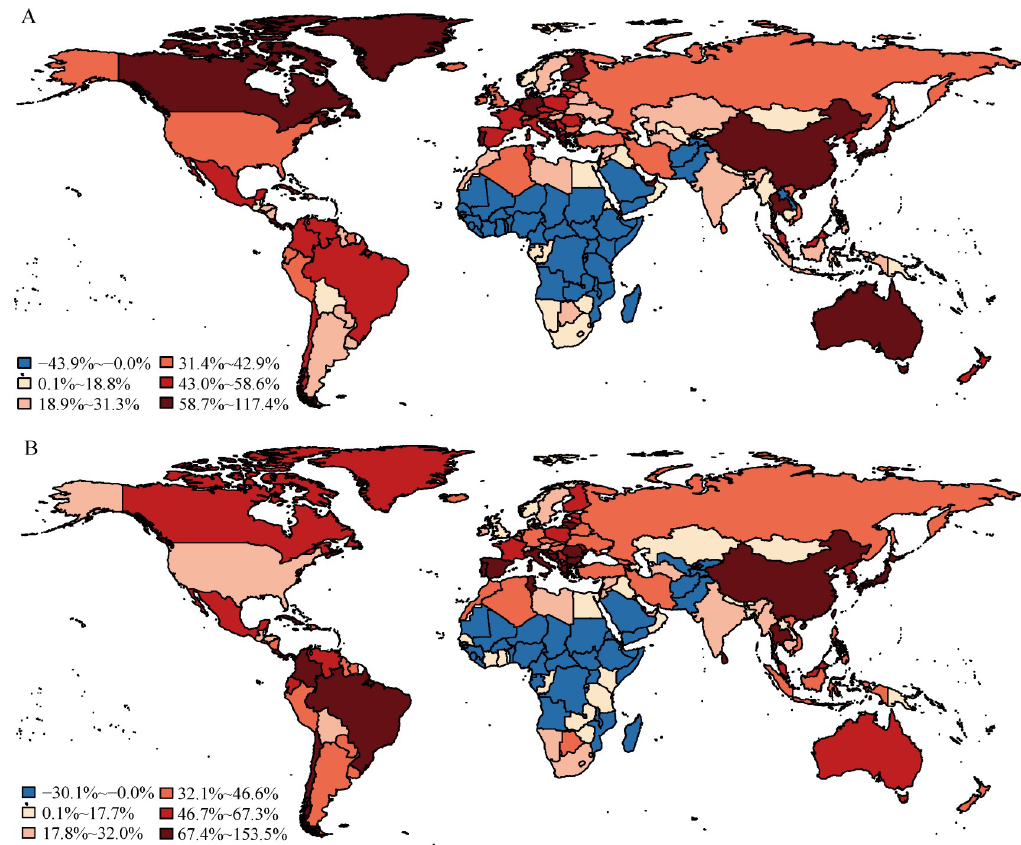
Fig 3. Proportion of deaths associated with population ageing between 1990 and 2017 in 195 countries and territories. (A) Male; (B) female. The attributed proportion was calculated as the change in total deaths attributed to population ageing between 1990 and 2017 divided by total deaths in 1990 × 100%. Countries and territories with negative attributed proportions were treated as a single category. Countries with positive attributed proportions were classified into 5 categories according to quintiles of positive attributed proportions. The maps were drawn using the R package “maps,” which was based on the data from the Natural Earth project.